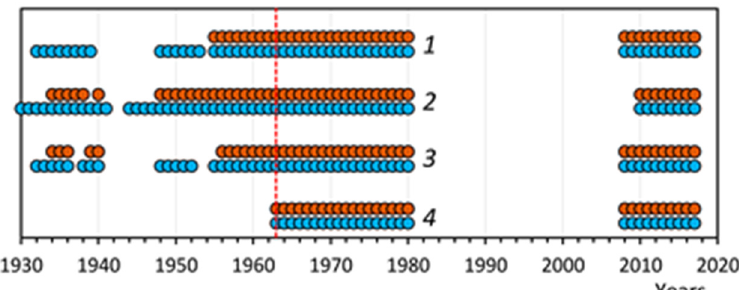
Figure 3. The years of observations (available data) for water discharge (in blue color) and suspended sediment load (in brown color) of the Kalaus River and the Ula River at the analyzed hydrological stations, the Stavropol Krai, SW Russia. The Kalaus River: 1 —at Sergiyevka, 2 —at Svetlograd, 3 —at Vozdvizhenskoye; 4 — the Ula River at Staromarievka (see Figure 1, Table 1).